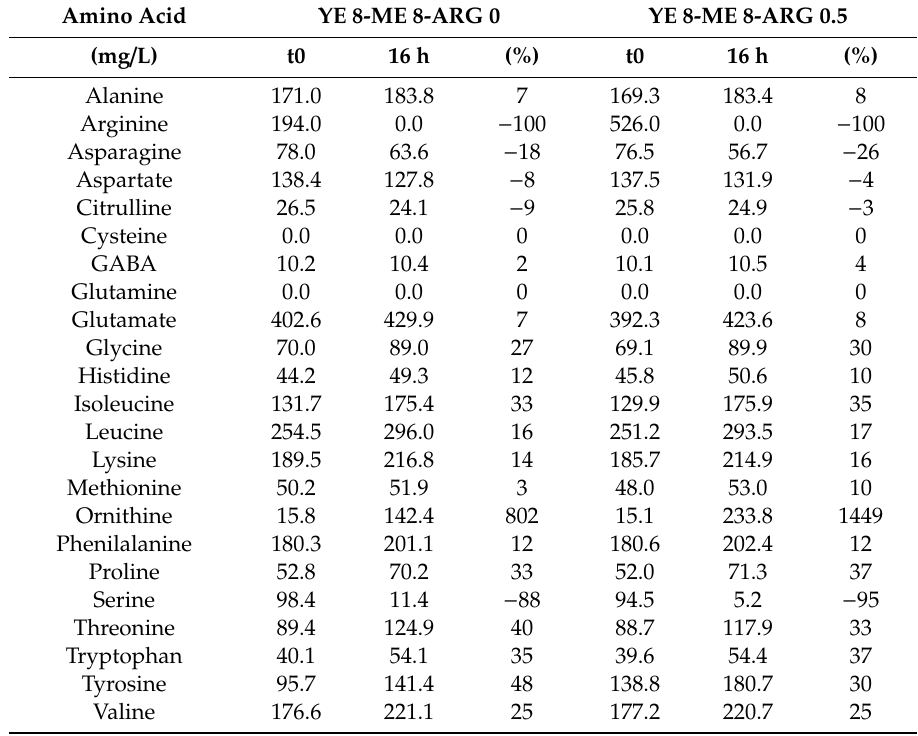
Table 5. Free amino acid concentration (mg / L) at t0 and 16 h incubation and percent variation in L. sakei grown cultures in SAK medium without or with L-arginine addition (0.5 g / L). Data reported as means, CV in the range